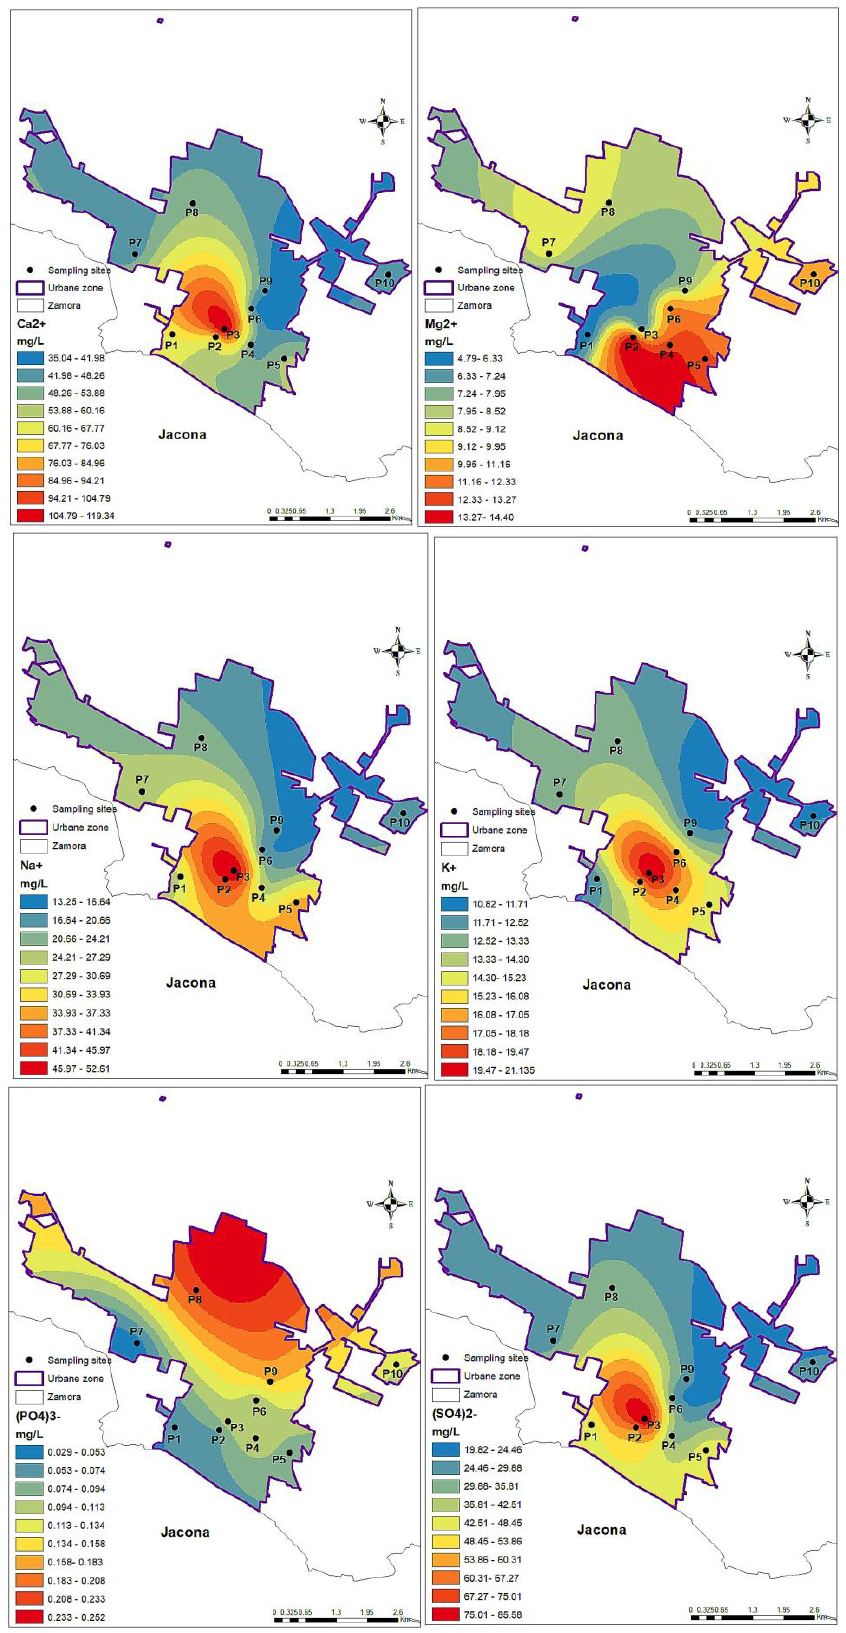
Figure 3. Distribution of the major ions content (mg / L): Ca 2 + , Mg 2 + , Na + , K + , PO 4 3 − , and SO 4 2 − in the studied zone.